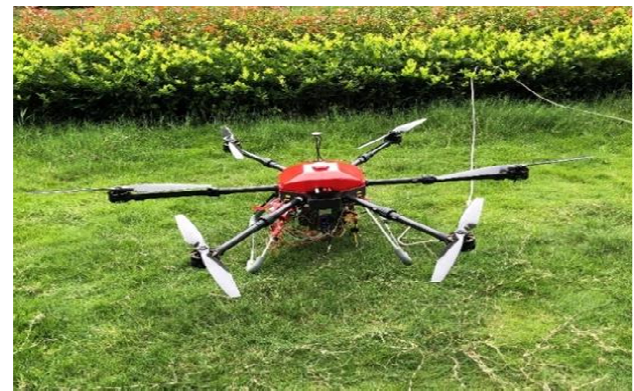
Figure 19. Real object drawing of multi rotor aircraft.